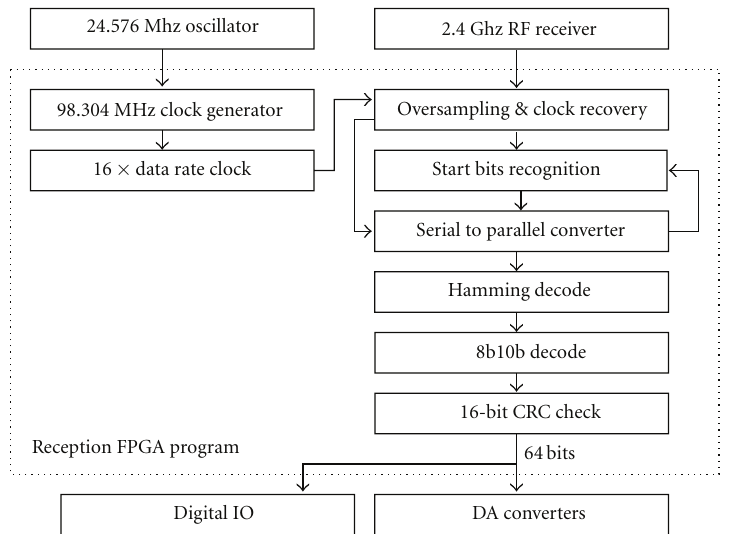
Figure 6: Schematic of FPGA receiver protocol.